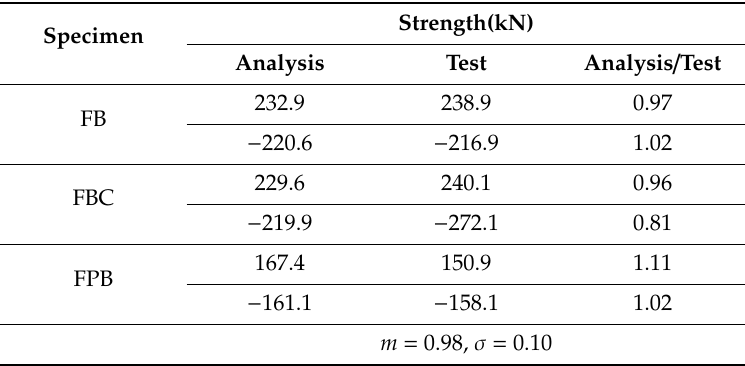
Table 2. Summary of test and analysis